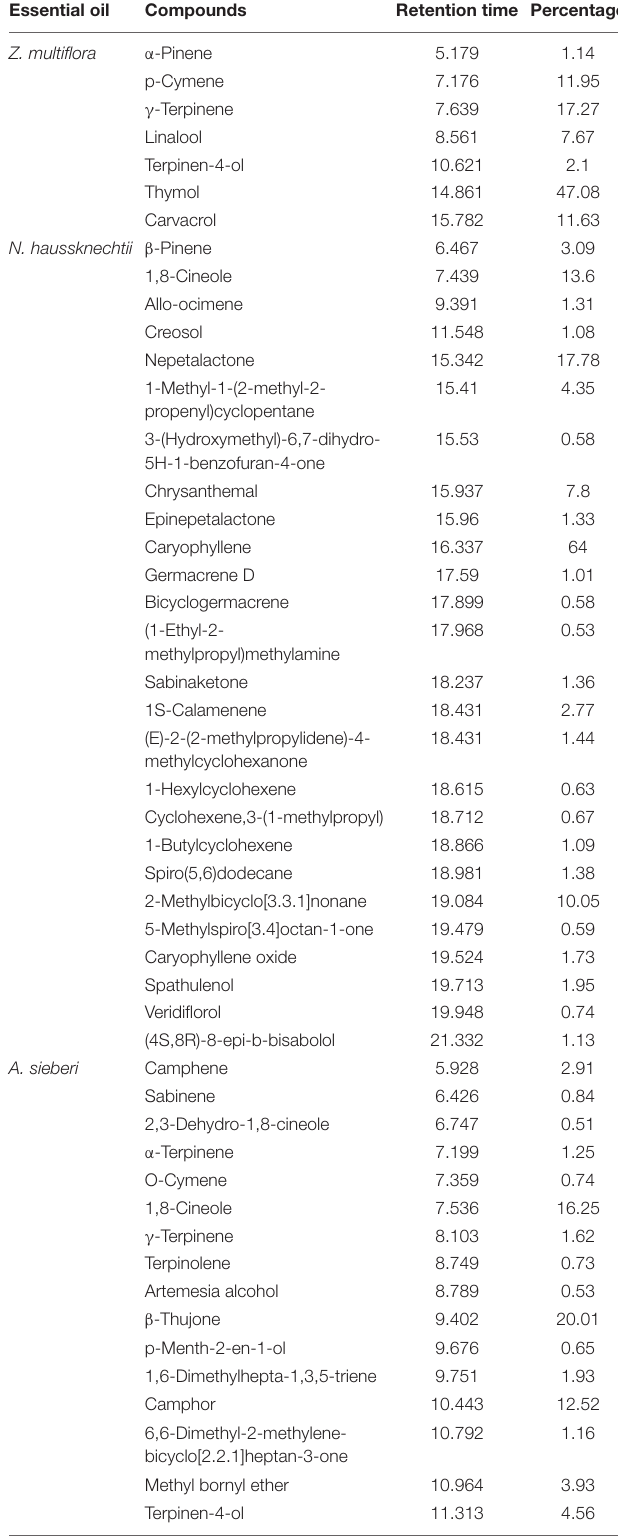
TABLE 1 | Type and percentages of main components identified in the essential oil of Z. multiflora , N. haussknechtii , A. sieberi , and C. aurantifolia . Essential oil